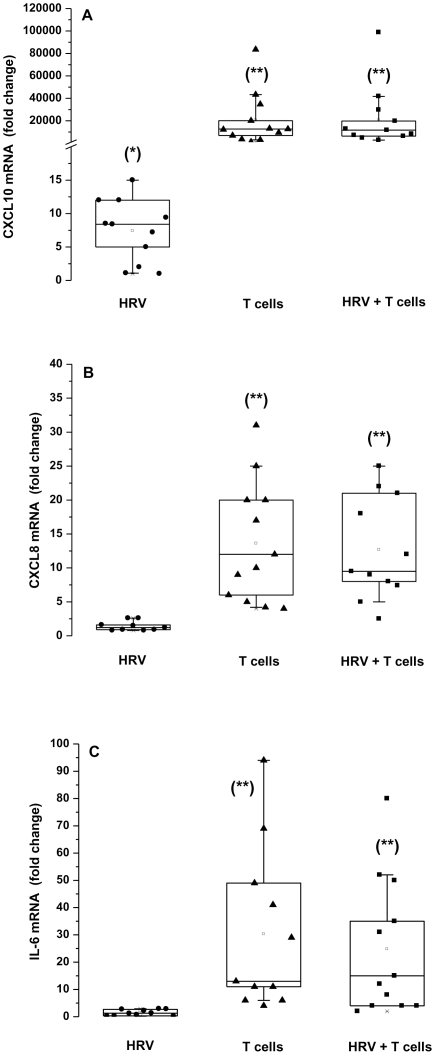
Epithelial CXCL10 mRNA is induced by HRV14 and T cells, CXCL8 and IL-6 mRNA are induced only by T cells.HNEC were exposed apically to HRV14 alone (HRV), or co-cultured with activated T cells alone (T cells), or exposed to HRV14 washed thoroughly then co-cultured with activated T cells (HRV+T cells). The expression of CXCL10 mRNA (A), CXCL8 mRNA (B) and IL-6 mRNA (C) was determined by real-time PCR. Data represent the fold increase relative to non-infected cells cultured in the absence of T cells. Shown are the boxplots with the 25th, 50th (median), 75th percentiles, the mean (open square), the maximum and the minimum values. *p<0.05 compared with control non-infected cells. **p<0.05 compared with HRV-infected cells.